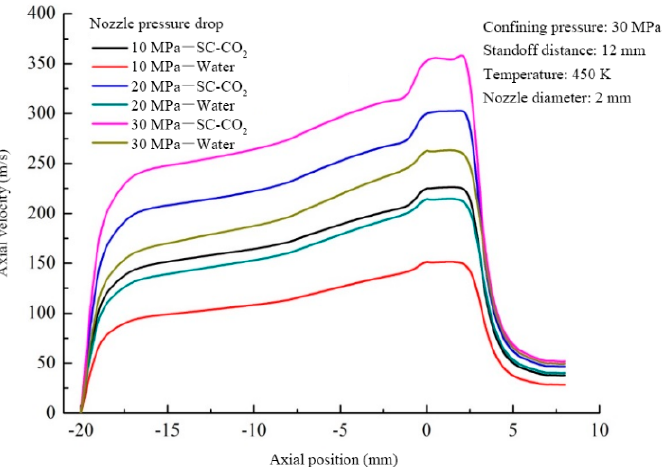
Figure 7. Pressure drop influence on the axial speeds of the swirling-round SC-CO 2 jet and water jet.